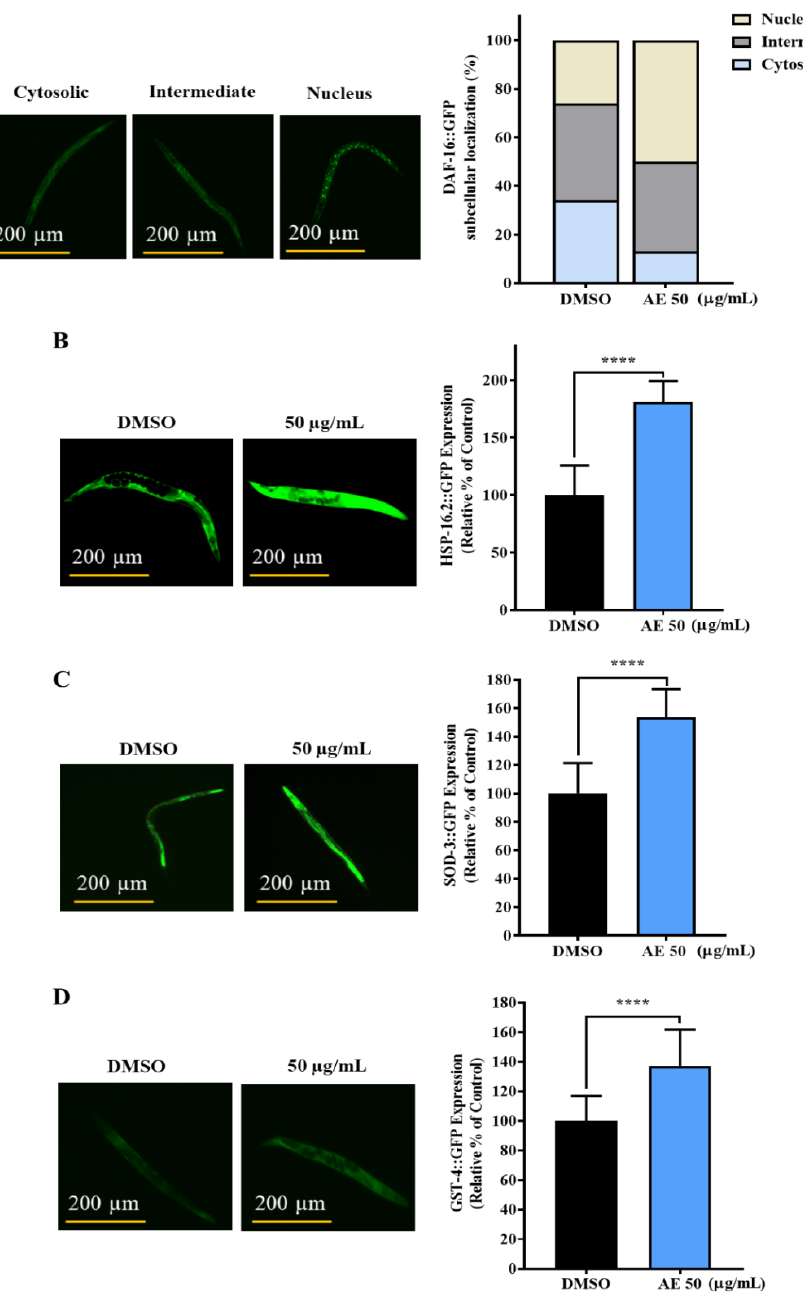
Figure 4. Effects of AE on DAF-16 cellular translocation and the expression of HSP-16.2, SOD-3 and GST-4 in GFP-tagged worms. ( A ) Subcellular localization of DAF-16::GFP worms treated with or without AE (50 µg/mL) for 96 h ( n = 30 worms/group). Subcellular localization was categorized into Cytosolic, Nucleus and Intermediate (between cytosolic and nucleus). ( B ) HSP-16.2::GFP worms treated or not treated with AE were cultured for 72 h and exposed to heat shock at 35 °C for 2 h ( n = 30 worms/group). ( C ) SOD-3::GFP and ( D ) GST-4::GFP AE-treated and non-treated worms were cultured for 72 h ( n = 30 worms/group). Statistical differences compared to control (DMSO) were considered significant at **** p < 0.001 by Student’s t -test. Data were represented by mean ± SD. Experiments were performed in triplicate determinations and representatives shown. Scale bar for GFP analysis = 200 µ